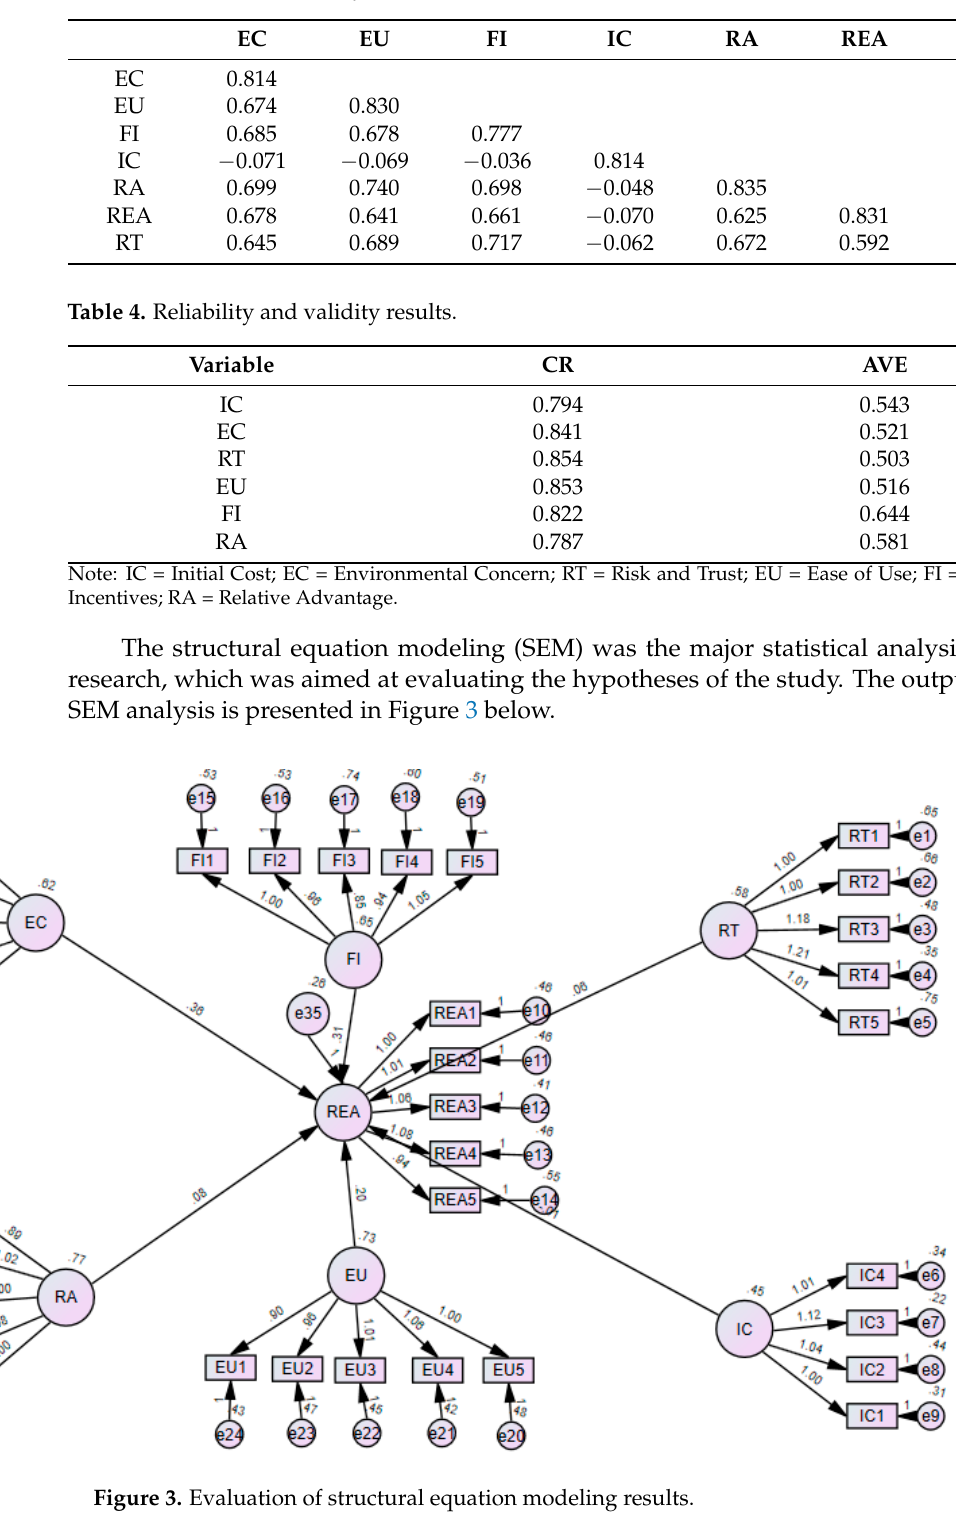
Table 3. Discriminant validity.